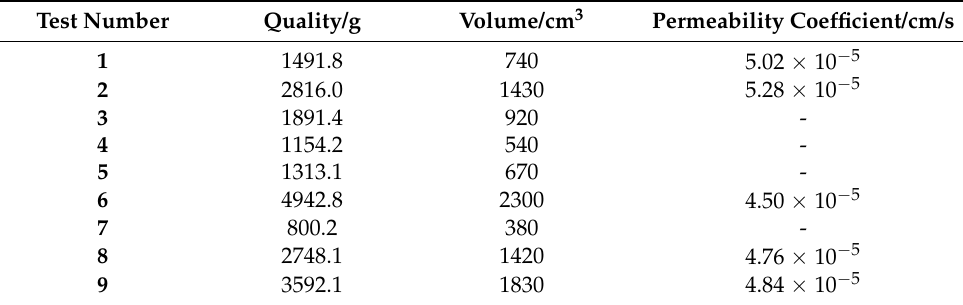
Table 6. Chemical grouted sands measurement